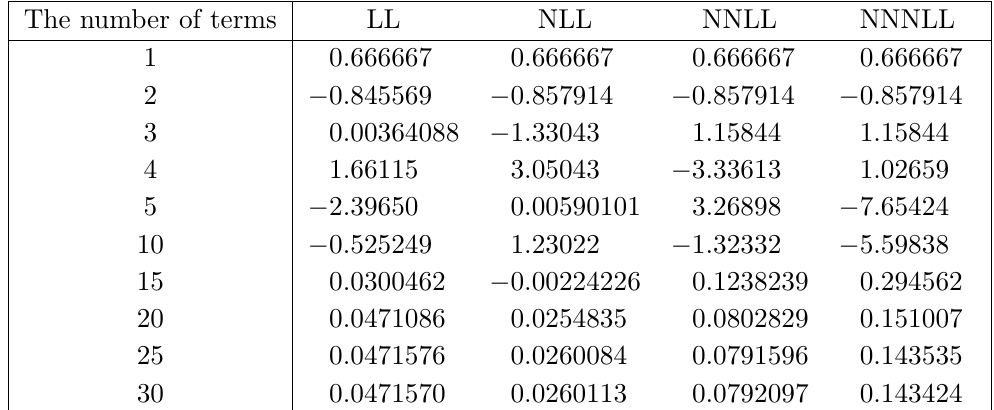
from truncated perturbative series of the 3 = 2